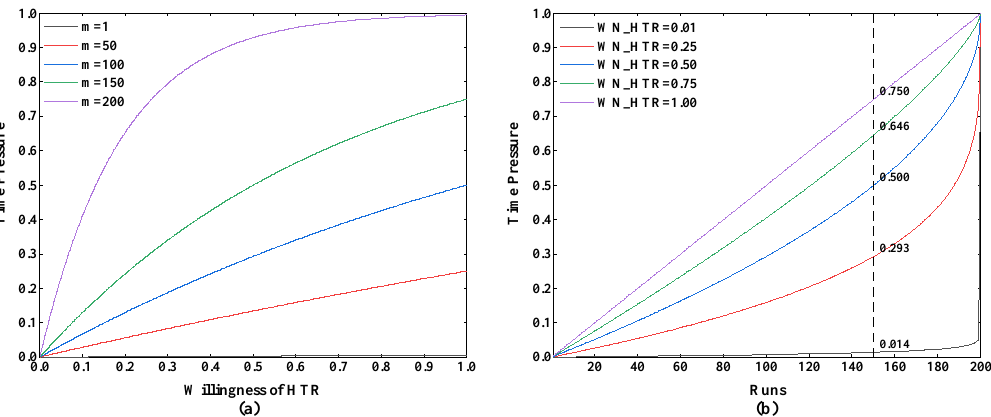
Figure 4. Time pressure of microgrid under ( a ) different historical trading records and ( b ) bidding